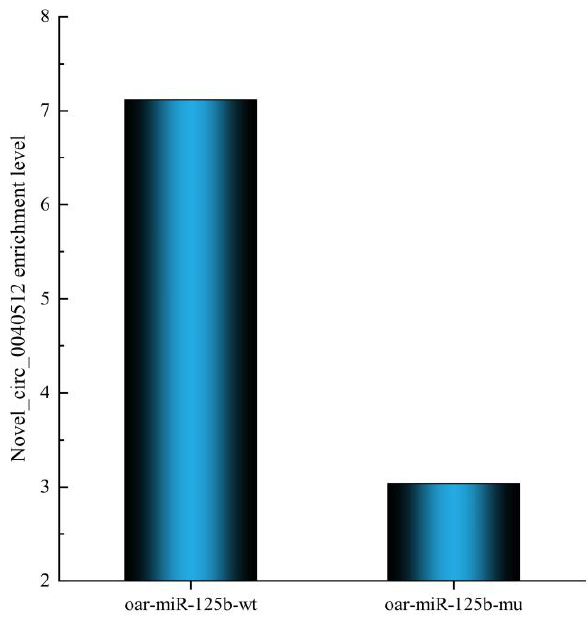
Figure 9. RNA pull-down assay to confirm the target relationship between novel-circ-0040512 and oar-miR-125b in cells.